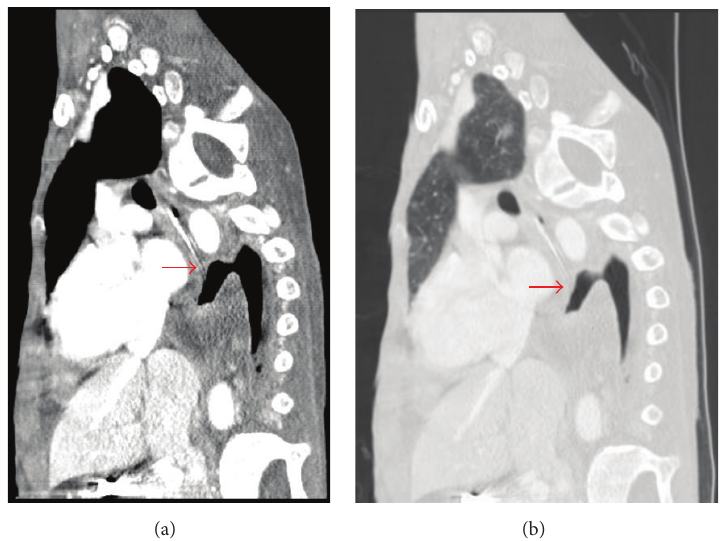
Figure 4: Chest CT: (a) mediastinal window, (b) lung window. Sagittal view showing esophageal tear and communication with pleura (red